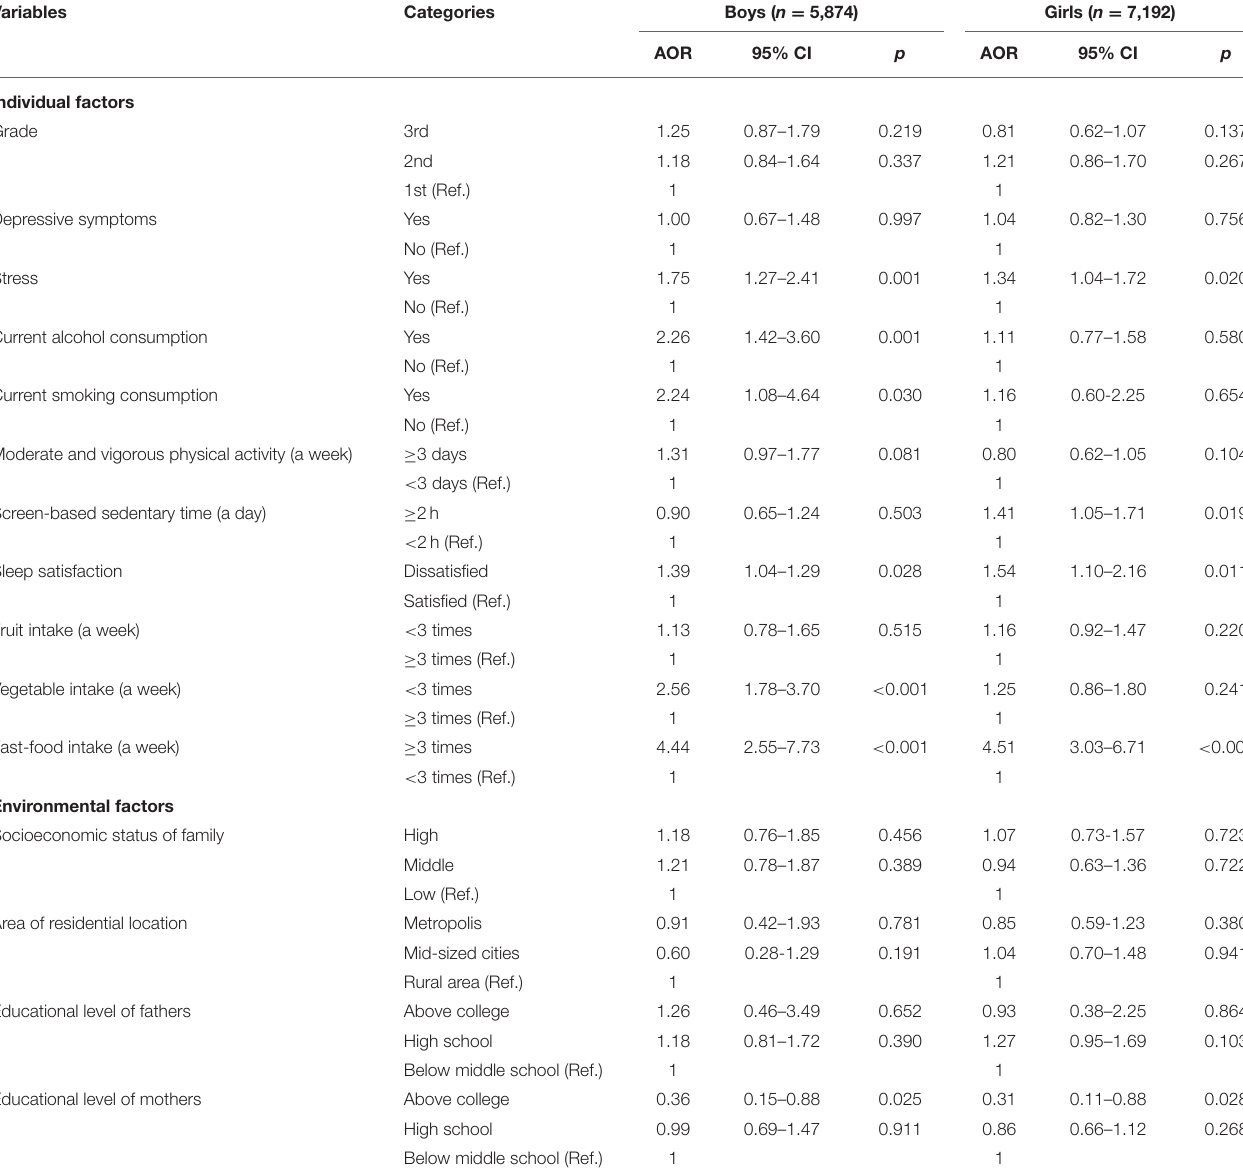
TABLE 3 | Individual and environmental factors associated with sugar-sweetened beverage consumption among high school